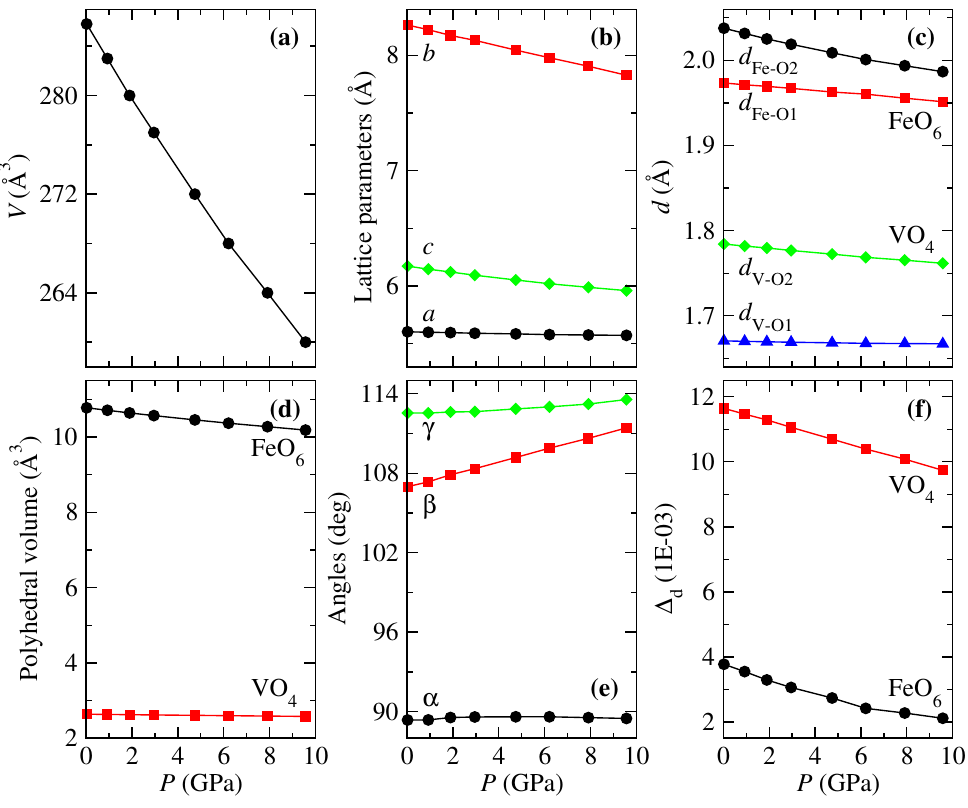
Figure 2. Structural parameters for FeVO 4 - II as a function of pressure: ( a ) volume, ( b ) lattice parameters, ( c ) interatomic distances, ( d ) polyhedral volumes, ( e ) angles, and ( f ) polyhedral distortion